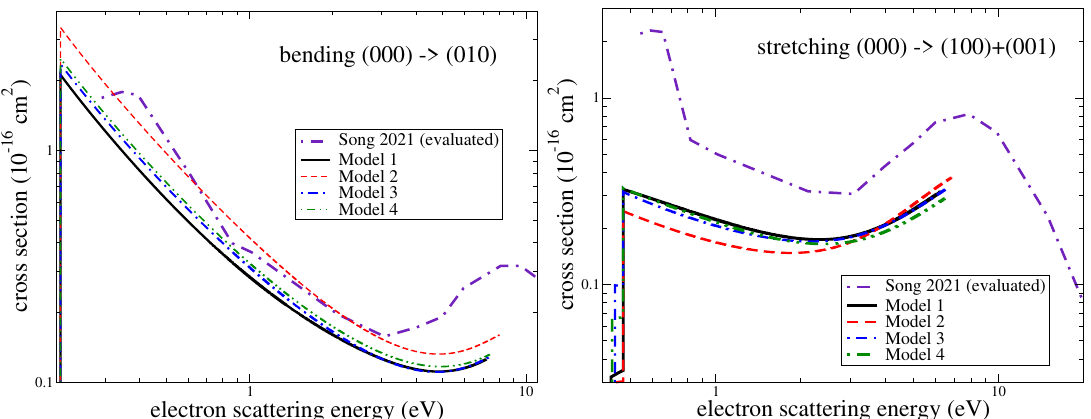
Figure 7. Cross sections for the excitation of the bending ( left panel ) and stretching ( right panel ) modes obtained using the four different models (see the text). Model 1 is used to produce final results of the study. The three other models, in which the basis set and the CAS were changed compared to Model 1, are used to assess the uncertainty of the results: Model 1—the cc-pVTZ basis and CAS 1 ; Model 2—the DZP basis and CAS 1 ; Model 3—the cc-pVTZ basis and CAS 2 ; Model 4—the cc-pVQZ basis and CAS 1